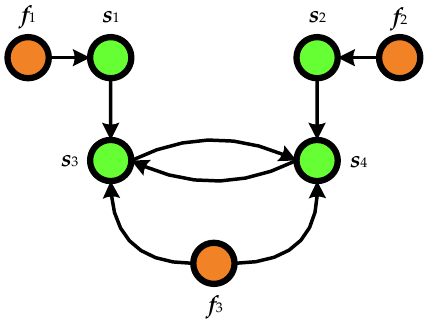
Figure 3. Directed graph (DG) of fault propagation for the NSSS of HTR-PM